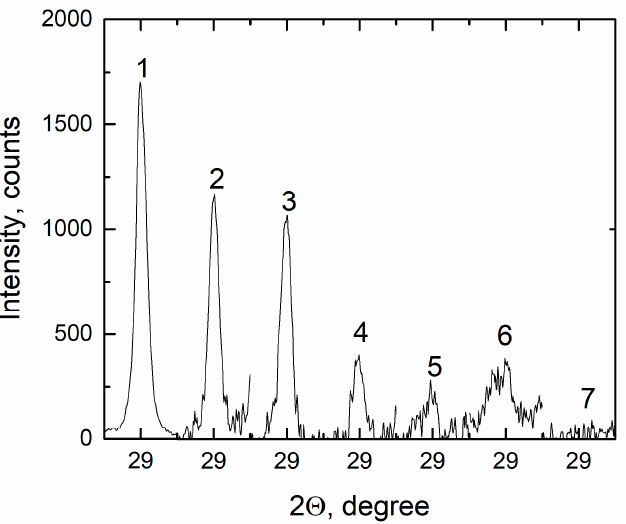
Figure 10. Intensity of the reflection (111) of the KF phase (1) FLiNaK; (2) FLiNaK + 0.5 mol.% NdF 3 ; (3) FLiNaK + 1.0 mol.% NdF 3 ; (4) FLiNaK + 2.0 mol.% NdF 3 ; (5) FLiNaK + 3.0 mol.% NdF 3 ; (6) FLiNaK + 4.0 mol.% NdF 3 ; (7) FLiNaK + 5.0 mol.% NdF 3 .